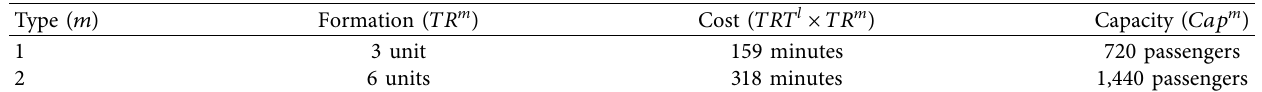
Table 14: The train formation